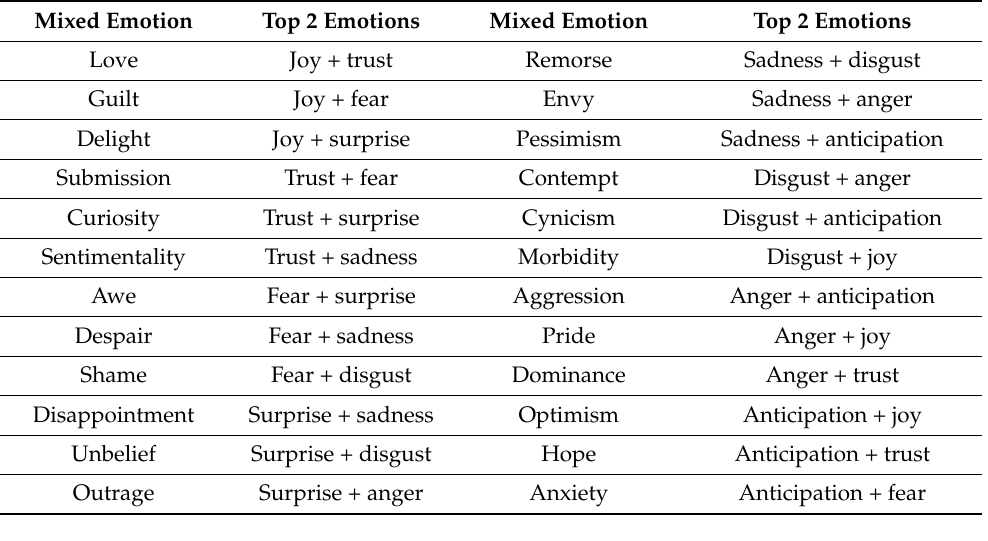
Table 2. Plutchik emotion mixing.